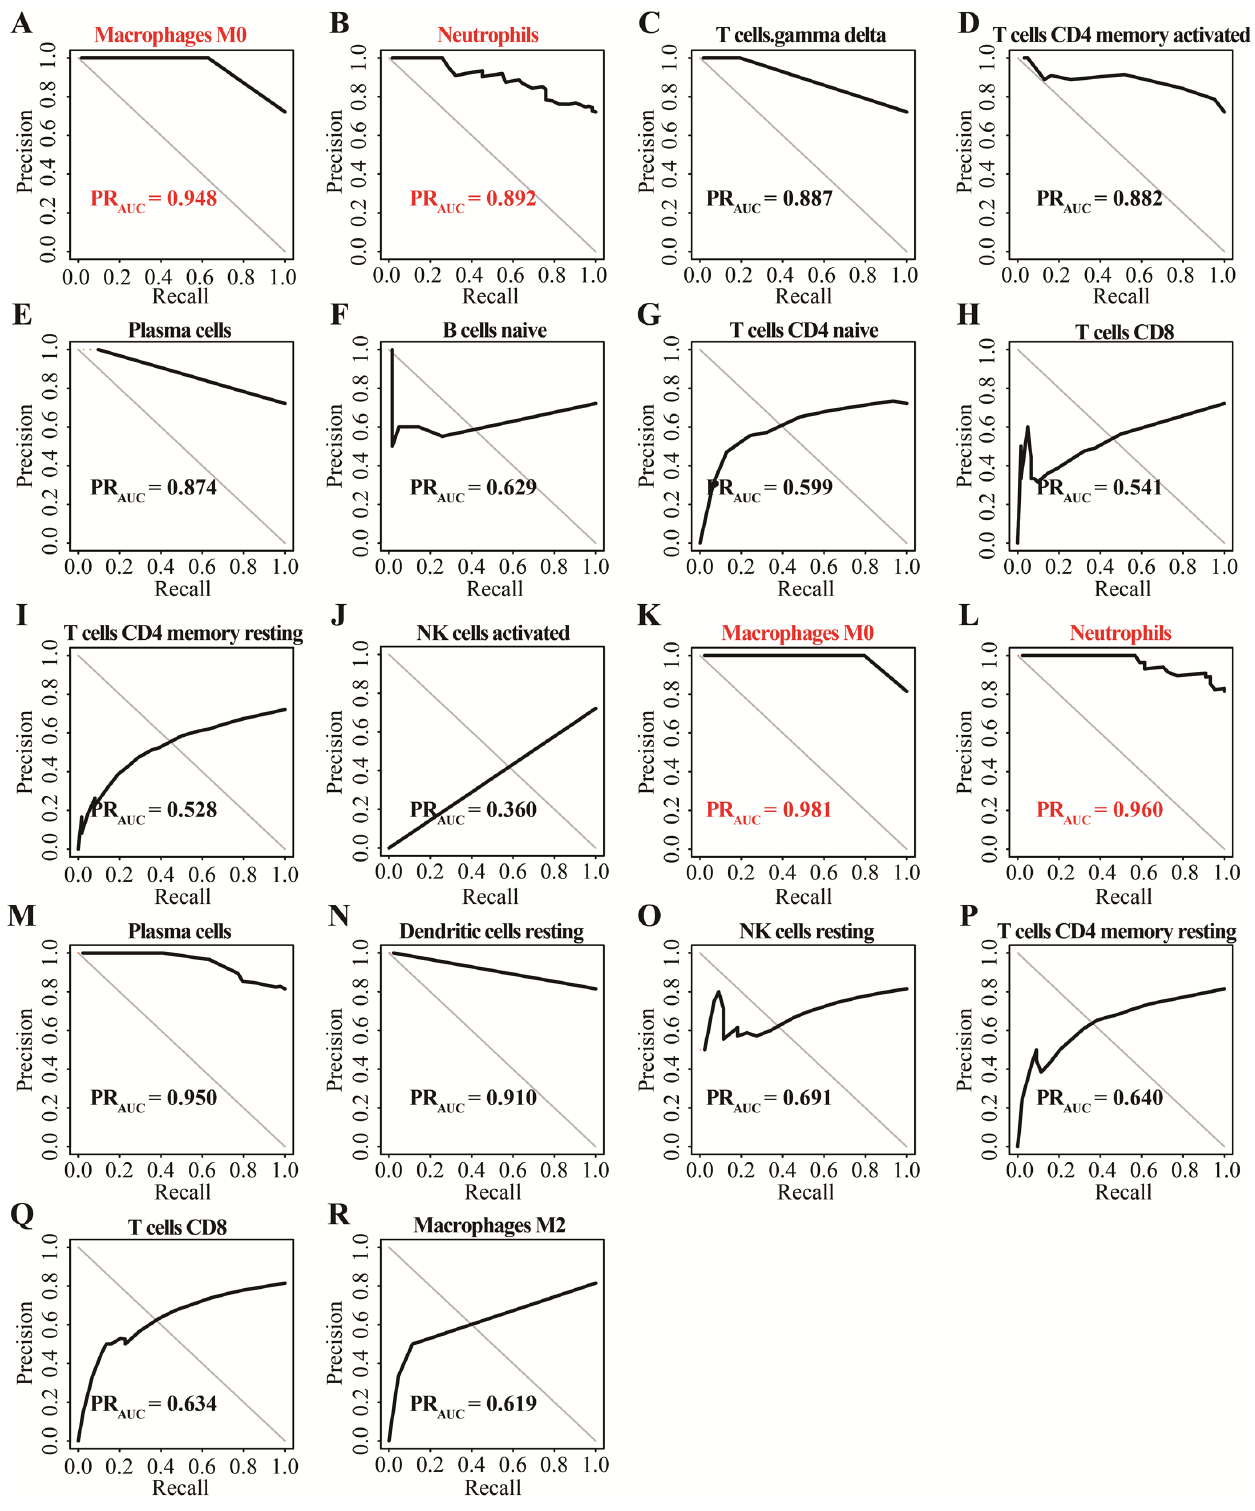
Figure 3. The determination of important immune cells using the precision–recall method. ( A – J ) The AUC of ten differentially distributed immune cells for outcomes in GSE152641. ( K – R ) The AUC of eight differentially distributed immune cells for outcome in GSE171110.